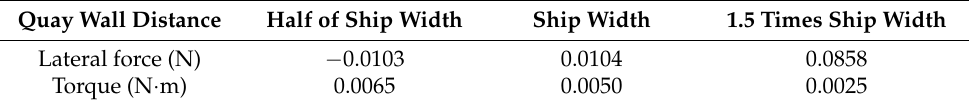
Table 2. Law of ship hull force changing with quay distance when the speed is 0.45 m/s.